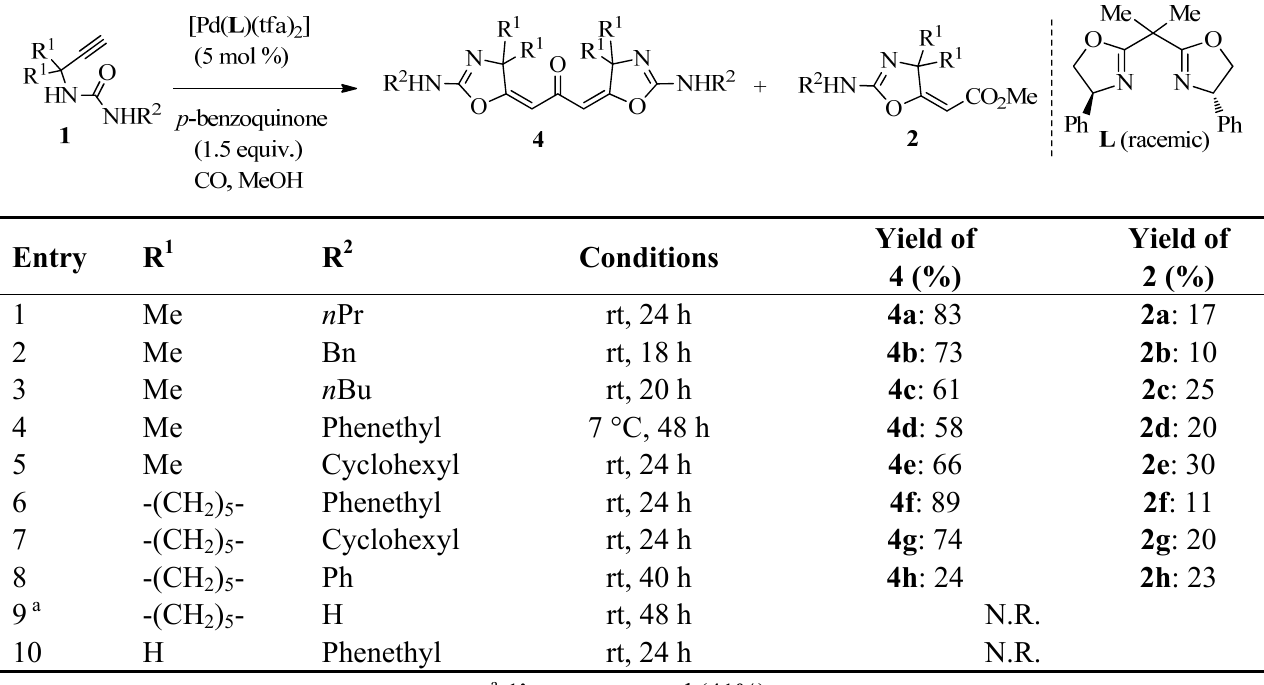
Table 2. CCC-coupling reaction of propargyl ureas 1